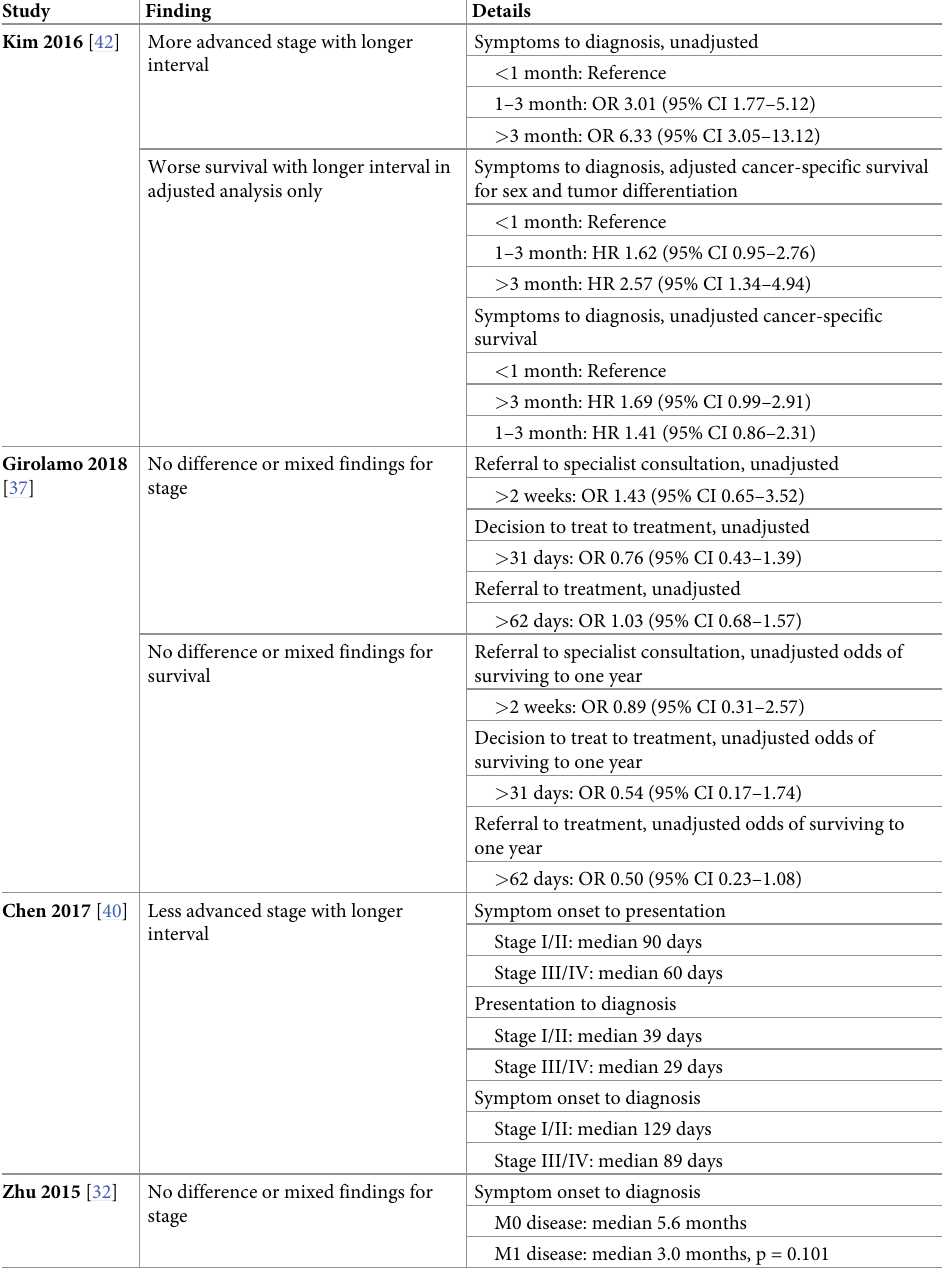
Table 3. Colorectal cancer outcomes (survival and advanced stage at presentation) among younger adults with longer intervals.